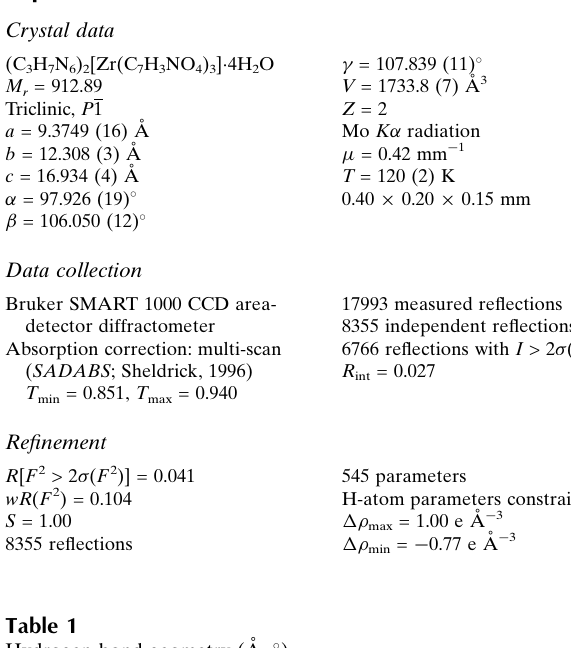
Hydrogen-bond geometry (A˚ , (cid:3)